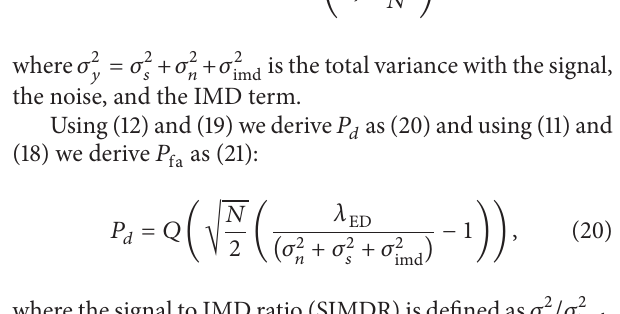
Simulated without IMD Simulation with IMD Figure 4: 𝑃 fa versus 𝑃 𝑑 with SNR at − 15dB, IMD of 2 dB, and 𝑁 = 1000